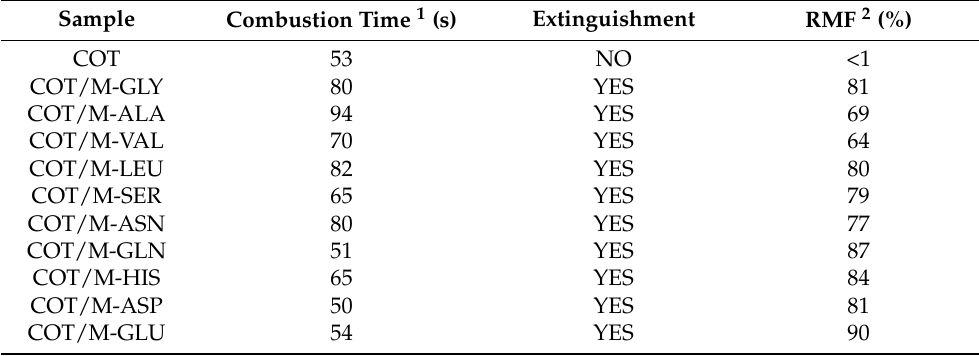
Figure 7. ( a ) Snapshots of the residues of 7% add-on, PAA-treated cotton samples after undergoing HFSTs. The PAA structures are reported in Table 2. ( b ) A sketch of the action mode of PAAs as intumescent FRs for cotton. Table 6. Combustion data of untreated and PAA-treated cotton fabrics with 7% add-on obtained from